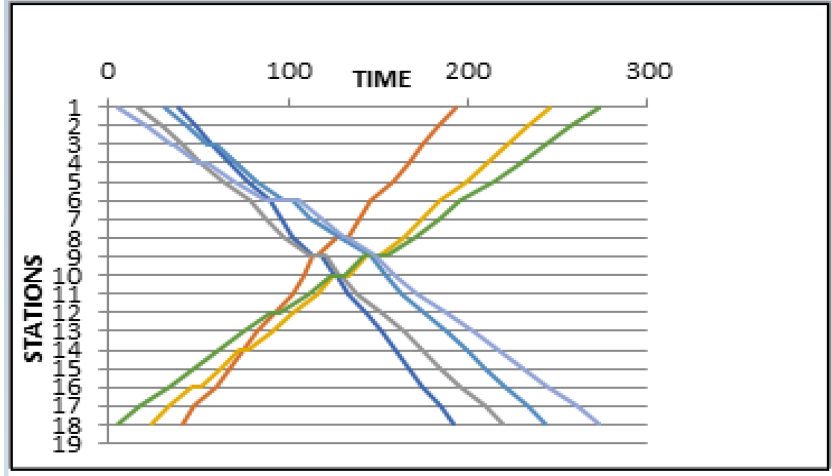
Figure 2. Optimal schedule of an example instance.